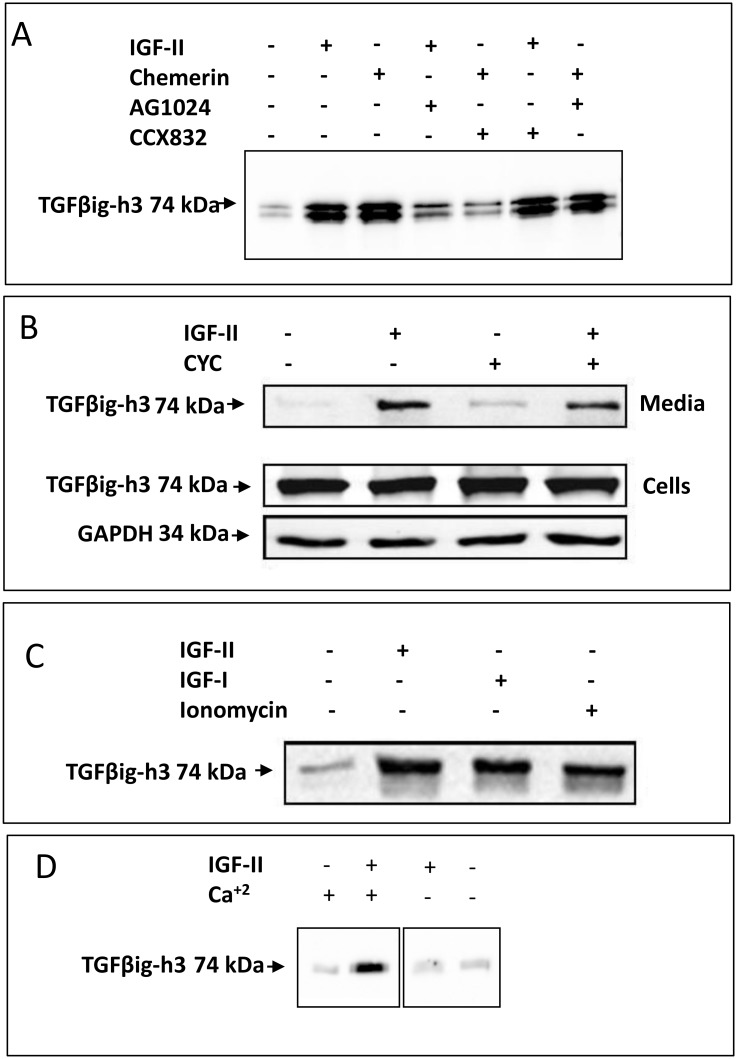
Secretion of TGFβig-h3 is stimulated by chemerin and IGF.
A. Western blot analysis of TGFβig-h3 in media from MSC cells shows stimulation by chemerin and IGF-II and inhibition by CCX832 and AG1042, respectively. B. Stimulated secretion of TGFβig-h3 is maintained after cycloheximide treatment. TGFβig-h3 abundance in cell extracts was unchanged (middle panel); GAPDH was used as a loading control for the cell extracts (bottom panel). C. The calcium ionophore, ionomycin (1μM) stimulated TGFβig-h3 secretion comparable to IGF-I (50ng.ml-1) and IGF-II (100ng.ml-1). D. In calcium-free medium stimulated secretion in response to IGF-II is inhibited.